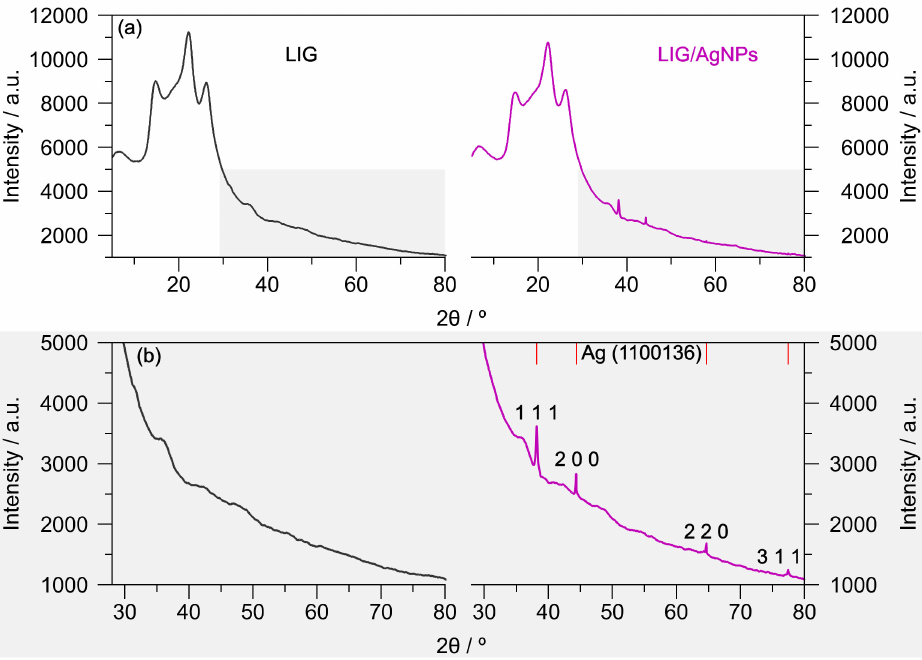
Figure 5. ( a ) Comparison of XRD spectra of LIG and LIG/AgNPs samples; ( b ) enlargement of the diffractogram in the region from 30 to 80 ◦